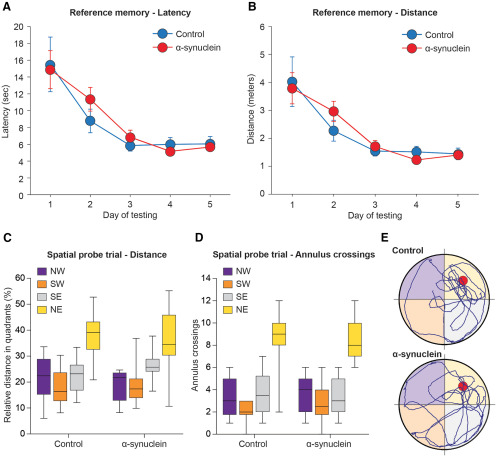
Performance during the Water maze reference memory test at three months postinjection. Average latency (A) and swim distance (B) required to locate the submerged platform during the acquisition phase of the spatial navigation task. Each sample point represents the mean value ± SEM for the block of four trials on each of the five consecutive days of testing. Lower diagrams illustrate the mean relative distance swum (C) and the average number of annulus crossings (D) in each quadrant during the spatial probe trial, once the escape platform was removed from the NE (training) quadrant. In E, the actual swim paths taken by representative animals from the different groups are shown. All groups exhibited an equally efficient performance, indicating that the α-syn injection had no effects on this task. NE, North-East; NW, North-West; SE, South-East; SW, South-West.